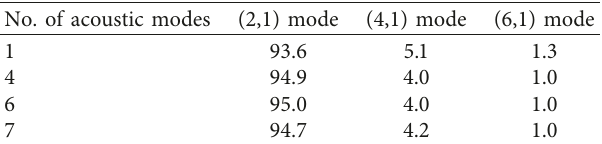
Table 5: Mode contribution at the (2,1) mode peak frequency ( κ � 0.2, ζ � 0.02).